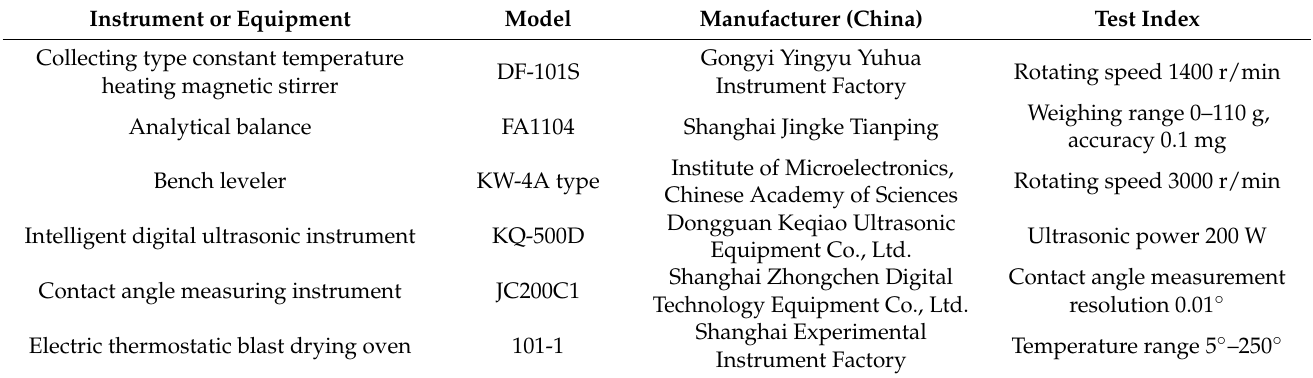
Table 2. Main experimental equipment and